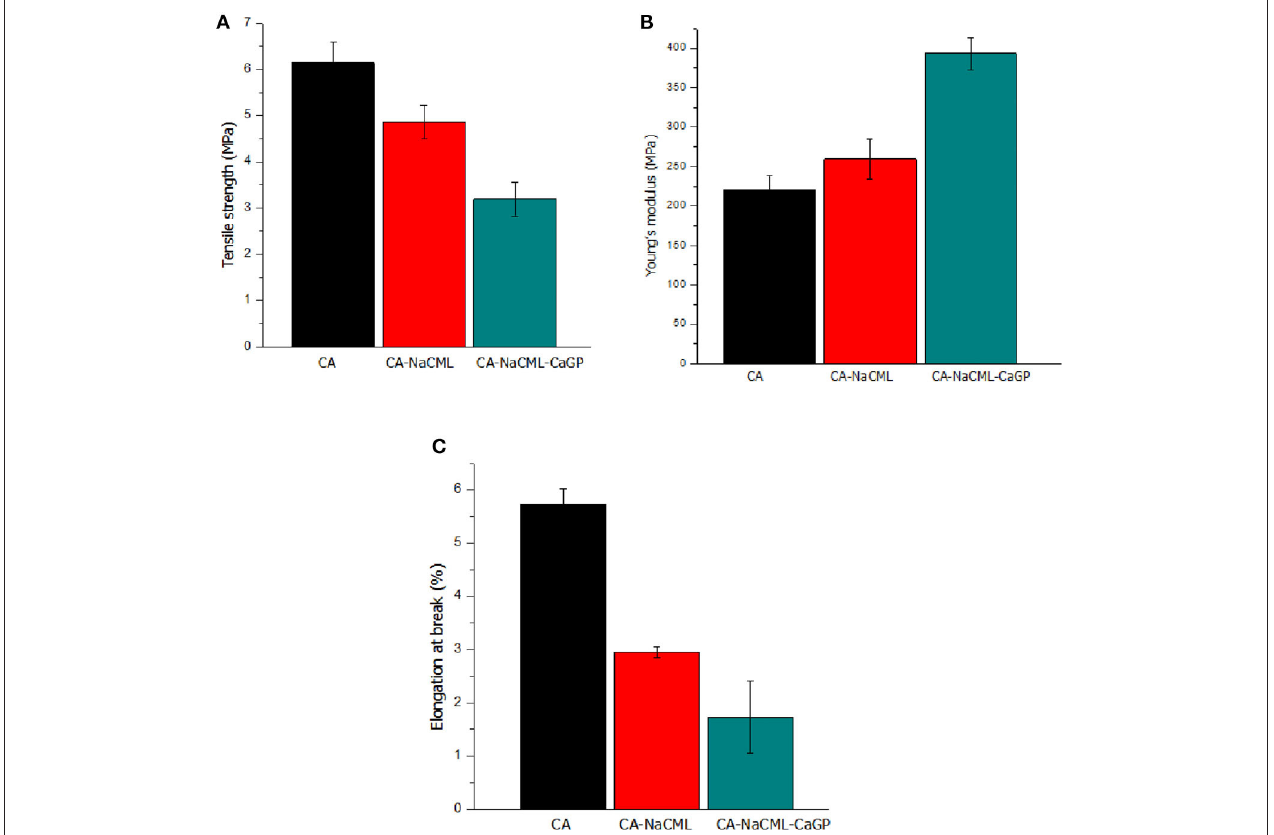
FIGURE 5 | Mechanical characteristics of the membranes (A) tensile strength, in MPa; (B) Young’s modulus, in MPa; and (C) elongation at break, in